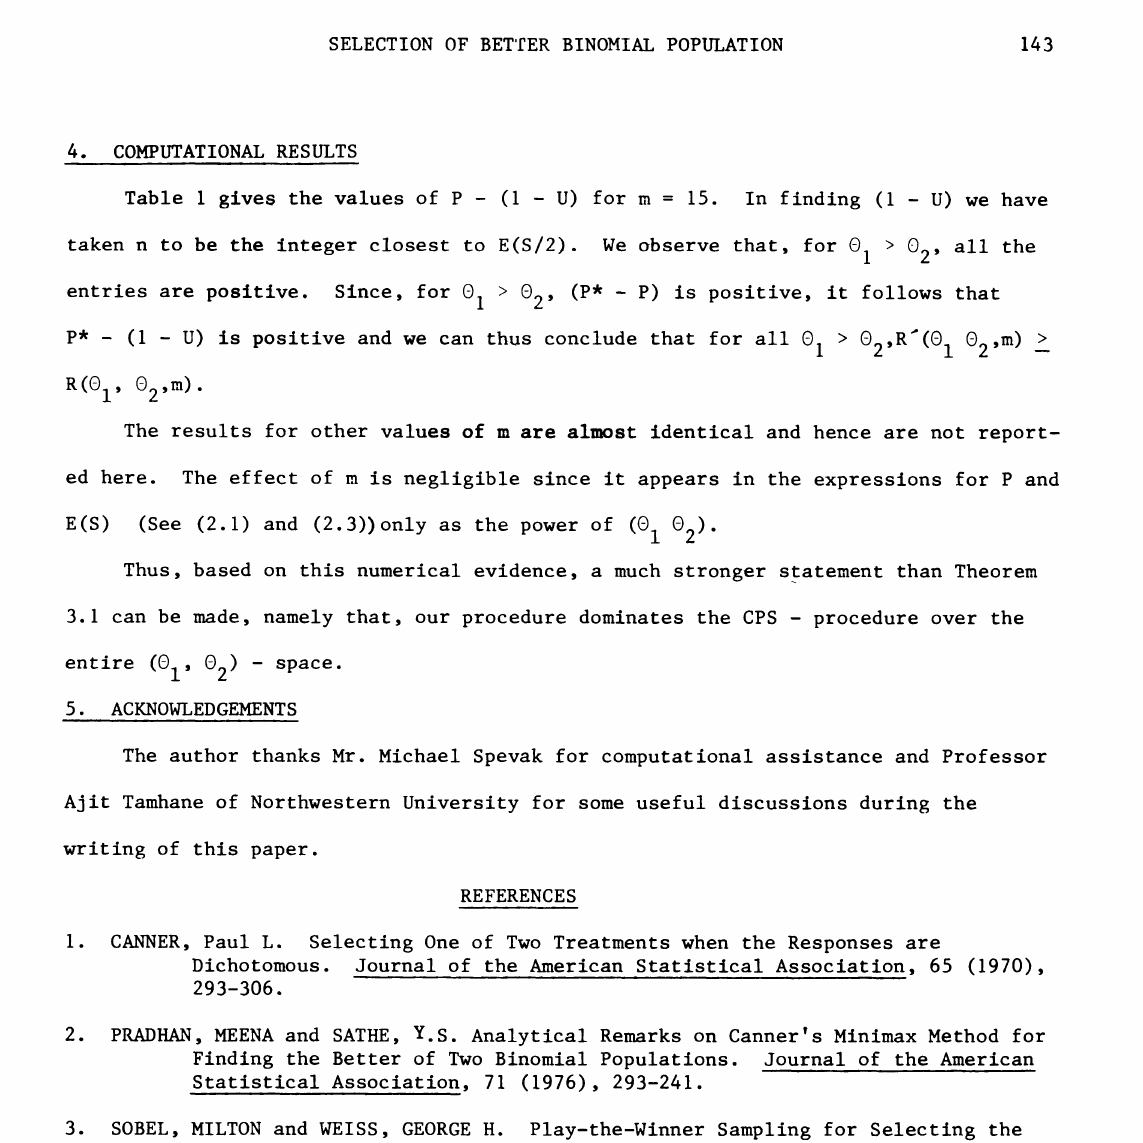
gives the values of P (I U) for m 15. In finding (I U) we